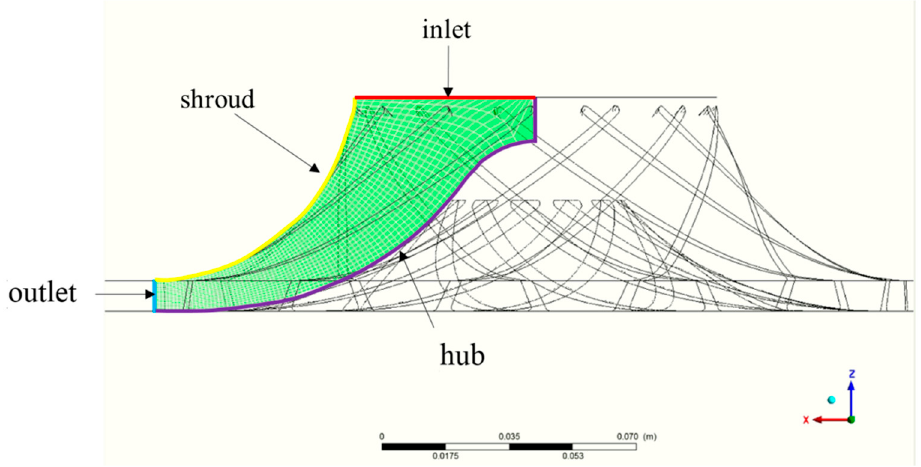
Figure 18. Schematic diagram of meridian plane flow field position.